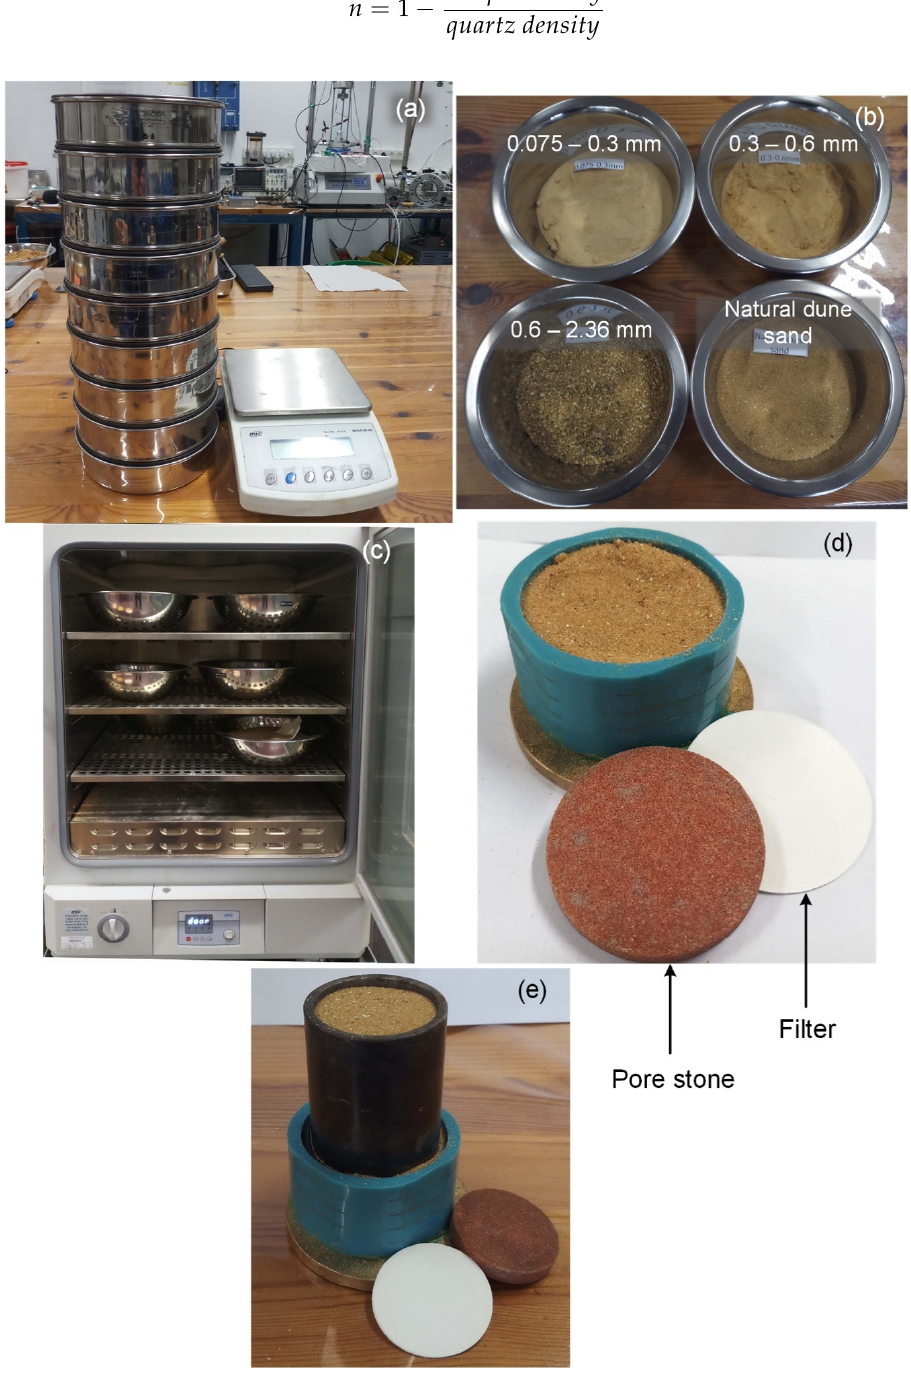
Figure 5. ( a ) The lab tools used for sand sieving and weighting. ( b ) The photos of the sand fractions used for the study. ( c ) The sand samples in the oven prior to drying. ( d ) The load cell for the OD study, including the filter and pore stone. ( e ) The load cell for the UCD and UCW studies, including the filter and pore stone.